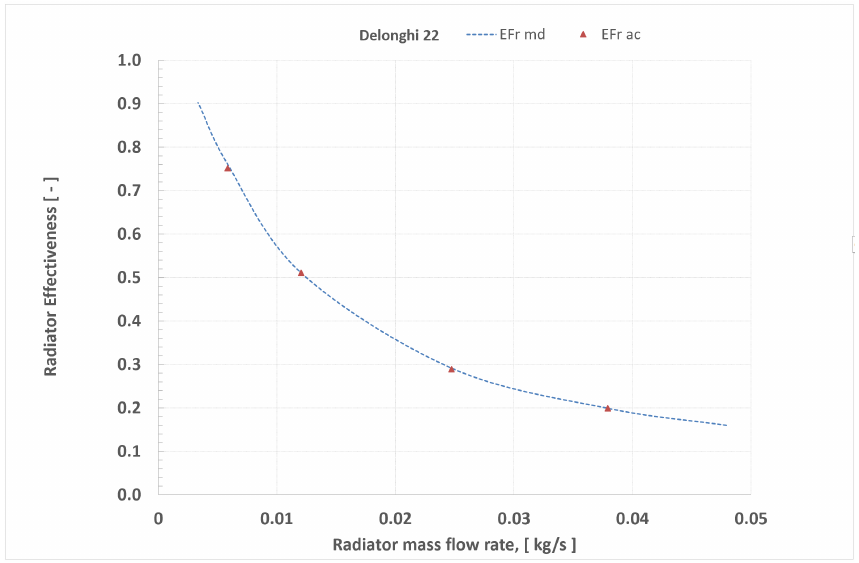
Figure 31. Radiator T -1, effectiveness according to the tests and simulations calculations by “ NEHTMiR md ” in the mass flow range m r from 39% to 356% of the nominal value. Example 1. q mx = 0.0307 kg/s, t s = 70.6 ◦ C, t i = 21.1 ◦ C, ∆ t 1 = 70.6 − 21.1 = 49.5 K (Q ac = 924 W, t rac = 63.4 ◦